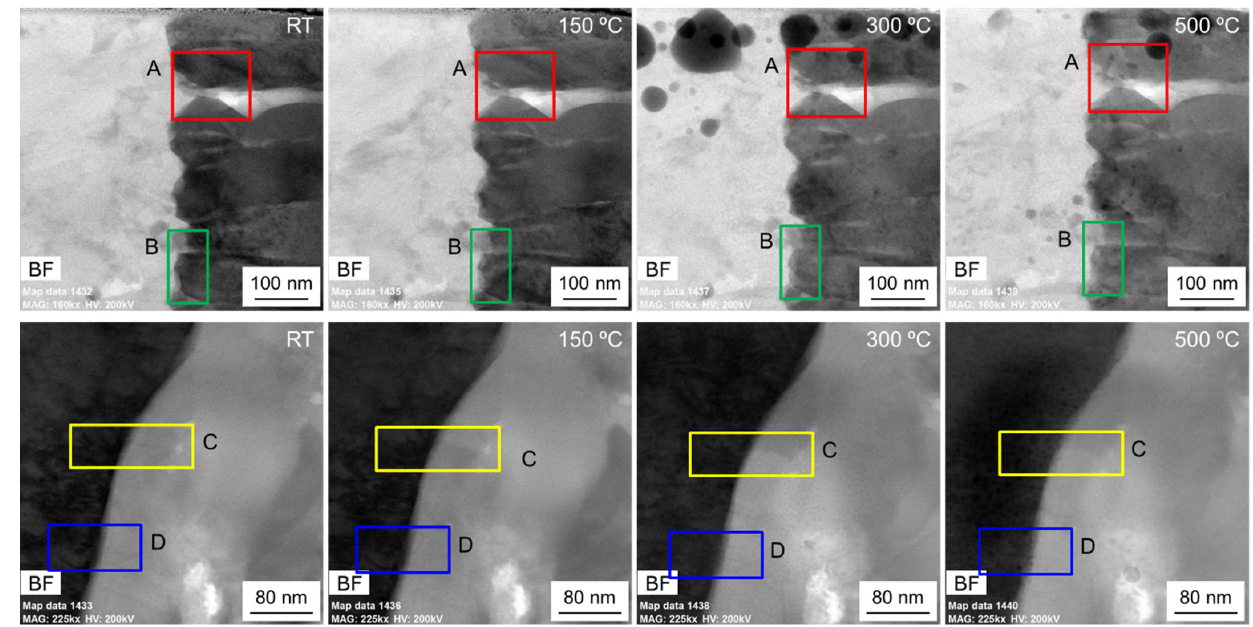
Figure 6. STEM-BF images of the observation area at different temperatures. Table 2. Proportion of different elements near TC/TGO interface at different temperatures